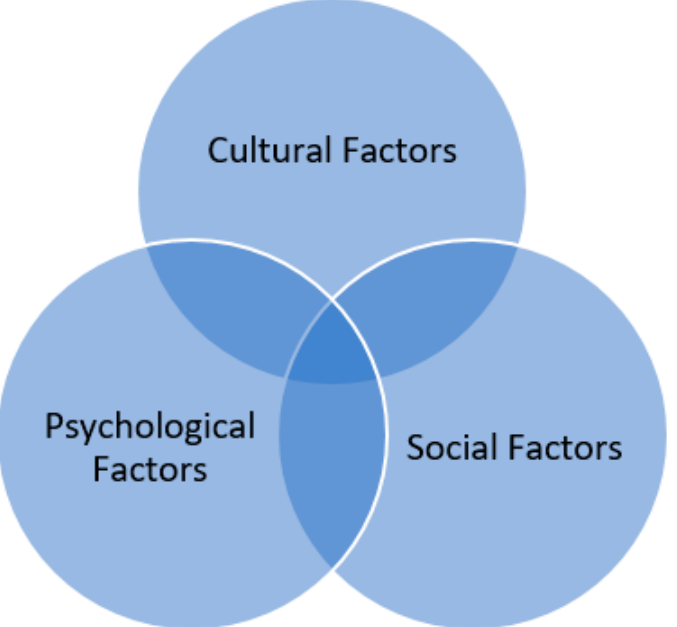
Figure 1. A proposed diagram representing the factors influencing access to and utilization of healthcare services by South Asian